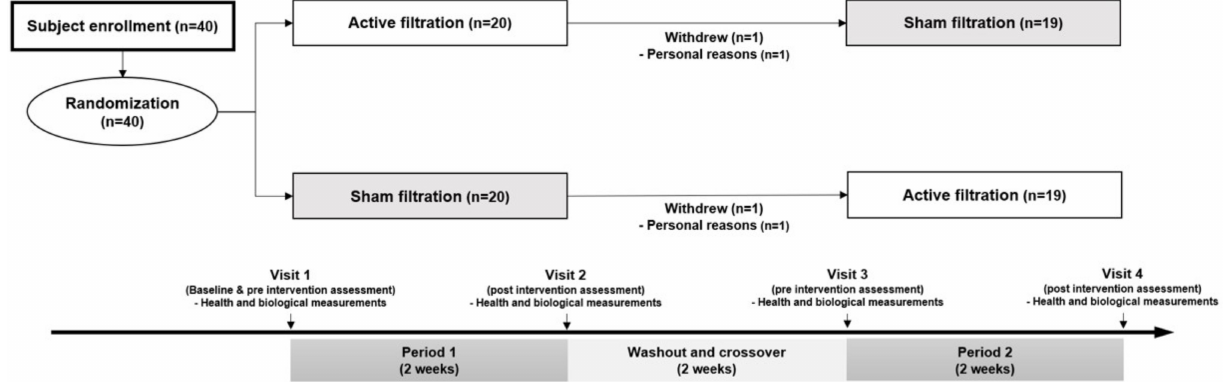
Figure 1. Flow chart of crossover trial. This randomized controlled trial consisted of three periods, two-weeks active and sham filtration interventions with two-week washout period. The indoor PM 10 concentration in the active filtration phase (18.6 ± 10.6 µ g/m 3 ) was lower than in the sham filtration phase (27.4 ± 18.2 µ g/m 3 ). The indoor PM 2.5 decreased to 12.3 µ g/m 3 in the active filtration phase as opposed to in the sham filtration phase. The indoor concentrations of PM 10 and PM 2.5 in the active filtration phase were 32.1% and 33.9% lower than those in the sham filtration phase, respectively (Table